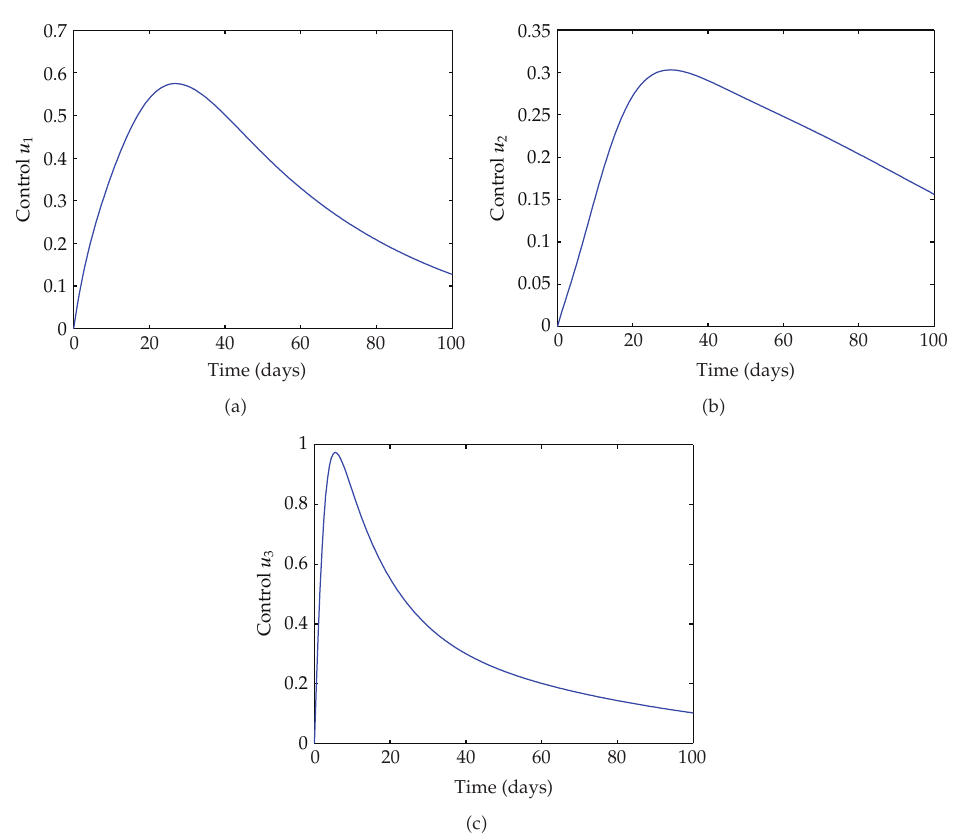
Figure 3: The plot represents the three controls (cid:6) 3.14 (cid:7) when A 1 (cid:9) 1, A 2 (cid:9) 1, A 3 (cid:9) 1, B 1 (cid:9) 200, B 2 (cid:9) 50, B (cid:9) 3